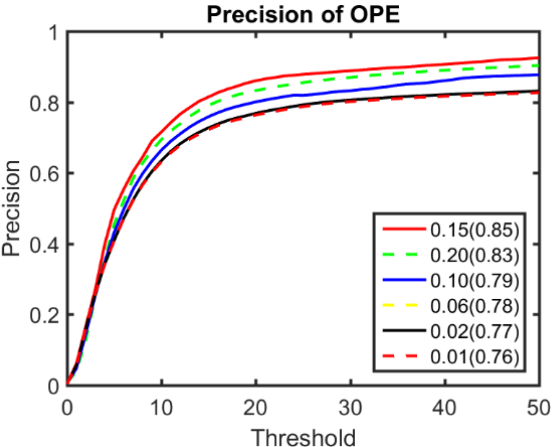
Figure 8. Experimental results of different angle thresholds of the OTB100 benchmark.